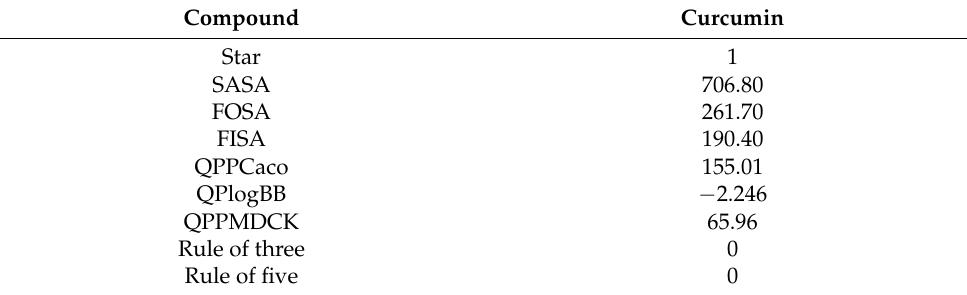
Table 4. ADMET analysis of